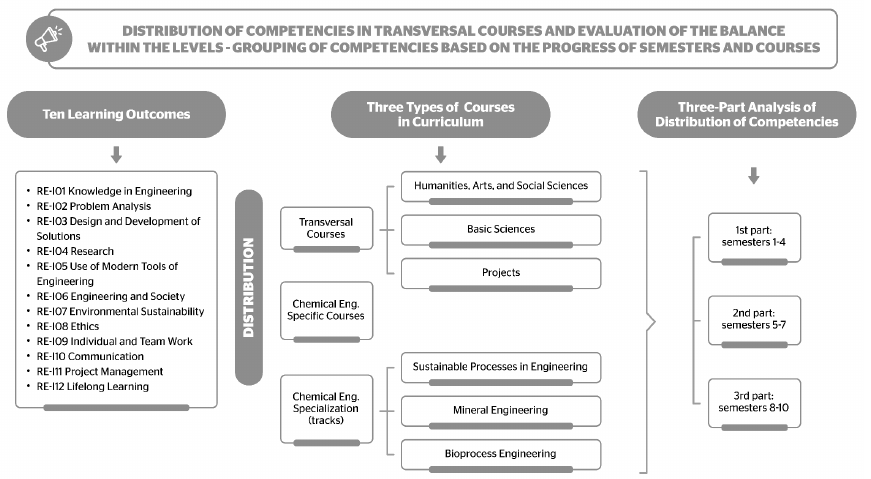
Fig. 7. Progressive distribution and grouping of learning outcomes by semesters and types of courses in the Chemical Engineering